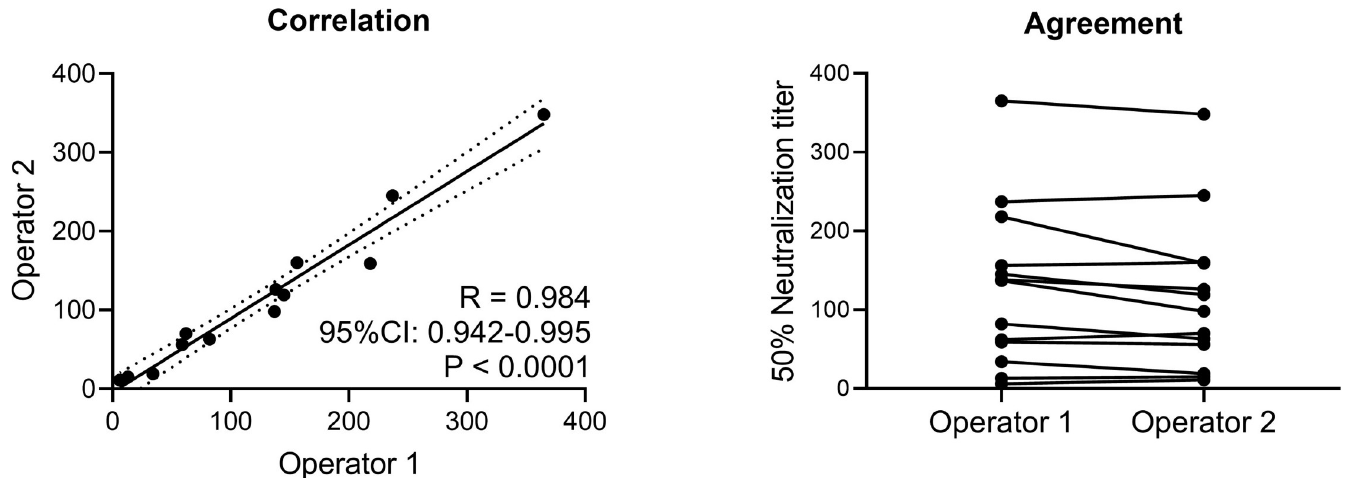
Fig 6. Operator-derived variation. Two operators tested the same clinical samples. Correlation and agreement between neutralization titers measured were assessed. ELISA primary antibody: rabbit mAb